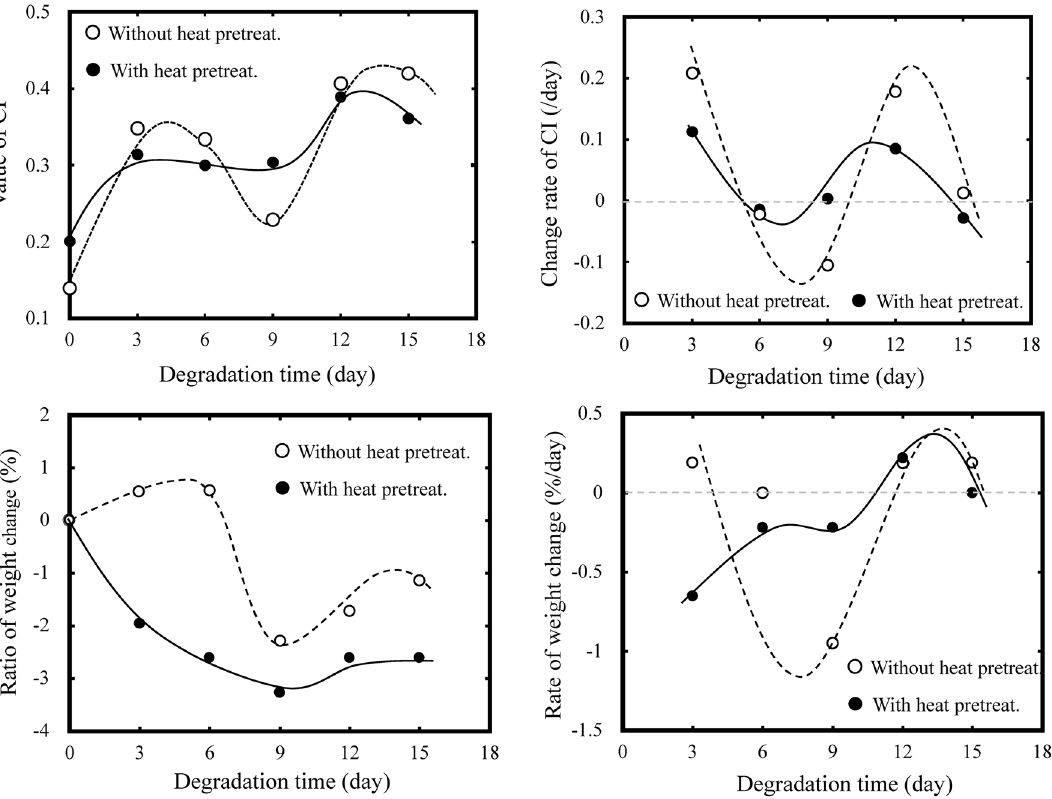
Fig. 5 Value and change rate of carbonyl index (CI), ratio and rate of weight change vs AOP degradation time of PP film with and without heat pretreatment